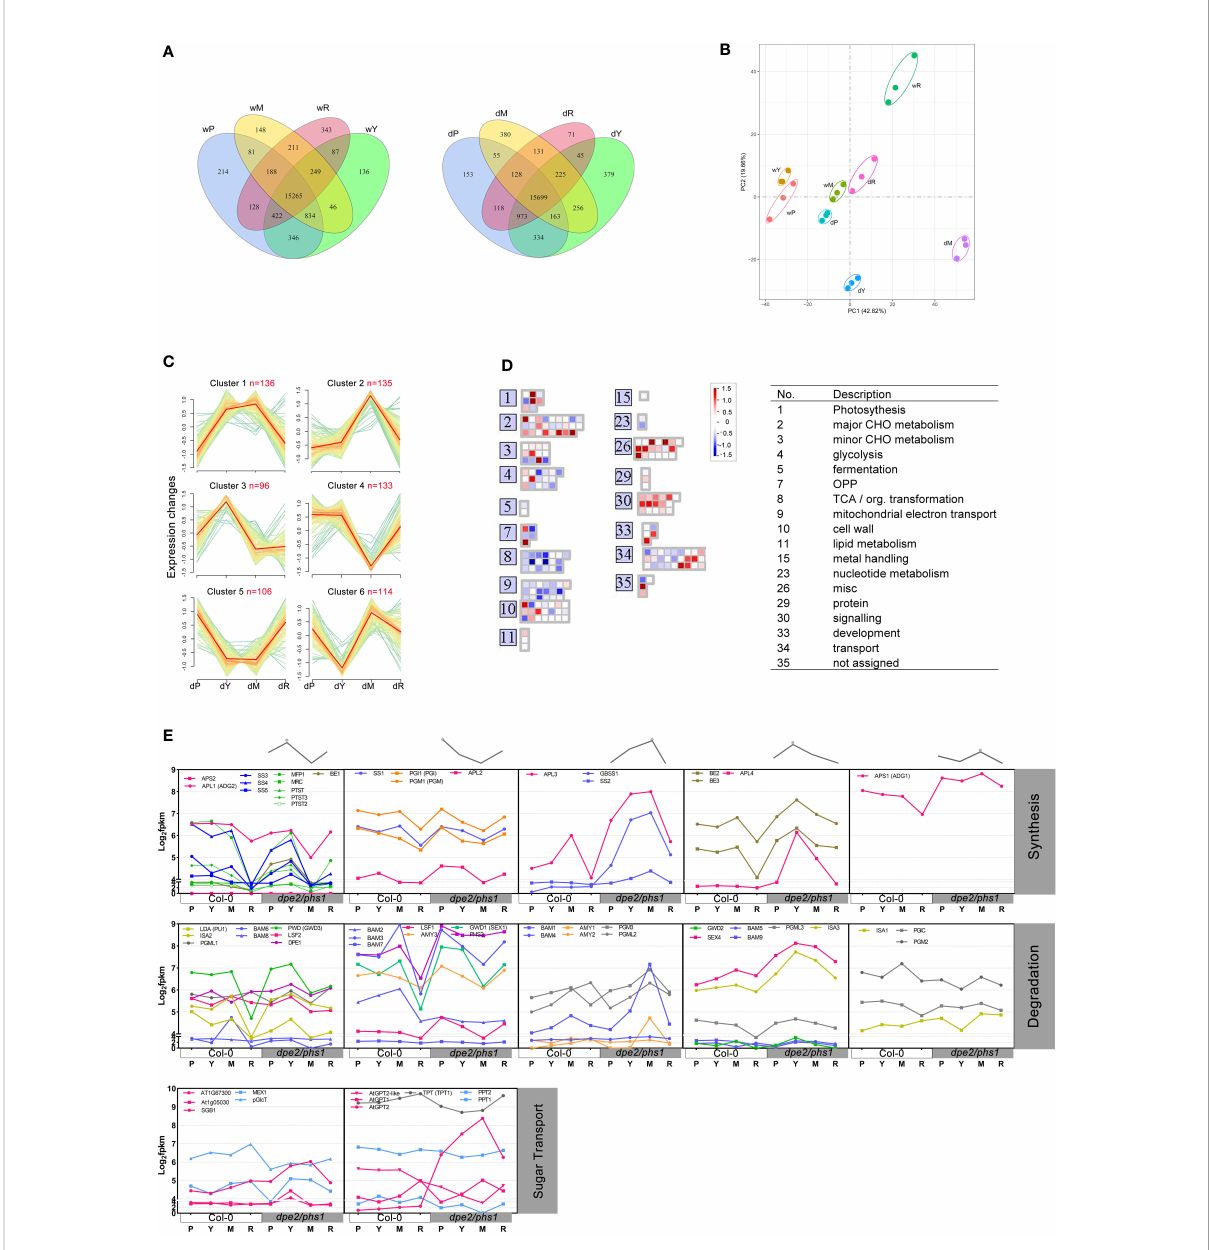
FIGURE 3 Differential gene expression in dpe2/phs1 and Col-0. w, wild-type; d, double mutant dpe2/phs1 : (A) Venn diagrams showing the number of signi fi cantly differentially expressed genes among the three periods, based on the cut-off of adjusted P value < 0.05. Young (Y) and mature leaves (M) in the Reduced Granule Number Period were analyzed separately; (B) PCA plot in different periods for dpe2/phs1 and Col-0. (C) Differential expression of 720 genes from nine pathways were assigned to six clusters. Each gene was normalized according to log 2 (FPKM+1). Each green line represents the expression level of a particular gene relative to the median expression level of all genes in that expression category. Orange lines represent the median expression; (D) Differential expression level of genes in clusters 3 and 6 were visualized with MAPMAN (Thimm et al., 2004). The differences between dY relative to the wY and dP relative to wP are shown in colors (blue, low expression; red, high expression); (E) Clustered starch synthesis, degradation, and sugar transport genes (log 2 (FPKM+1)). The grey lines at the top represent the gene expression pattern, which is only based on the trend in dpe2/phs1 . The synthesis and degradation enzymes in the same column shared the same pattern. The abbreviations for the starch metabolism-related genes are given in Table